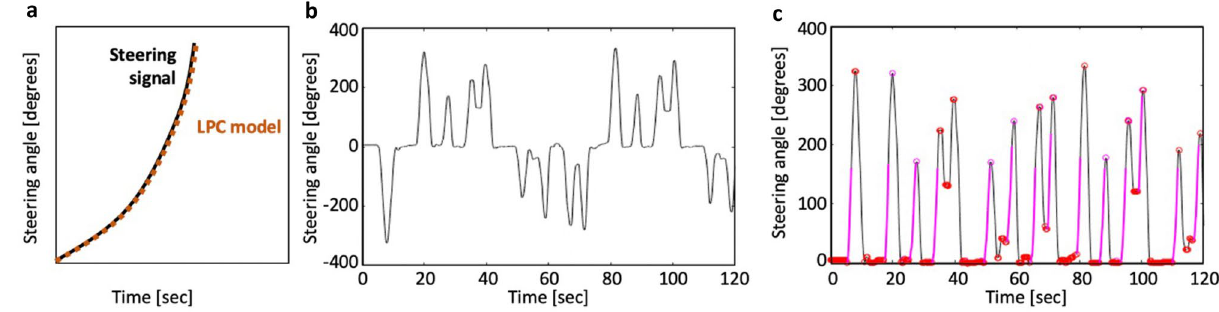
Figure 5. Steering wheel stress sensing method. ( a ) A typical steering wheel movement and corresponding LPC trajectory. ( b ) Steering angle data for one participant with negative values for counter clockwise rotation; and, ( c ) processed steering angle data along with the selected turn